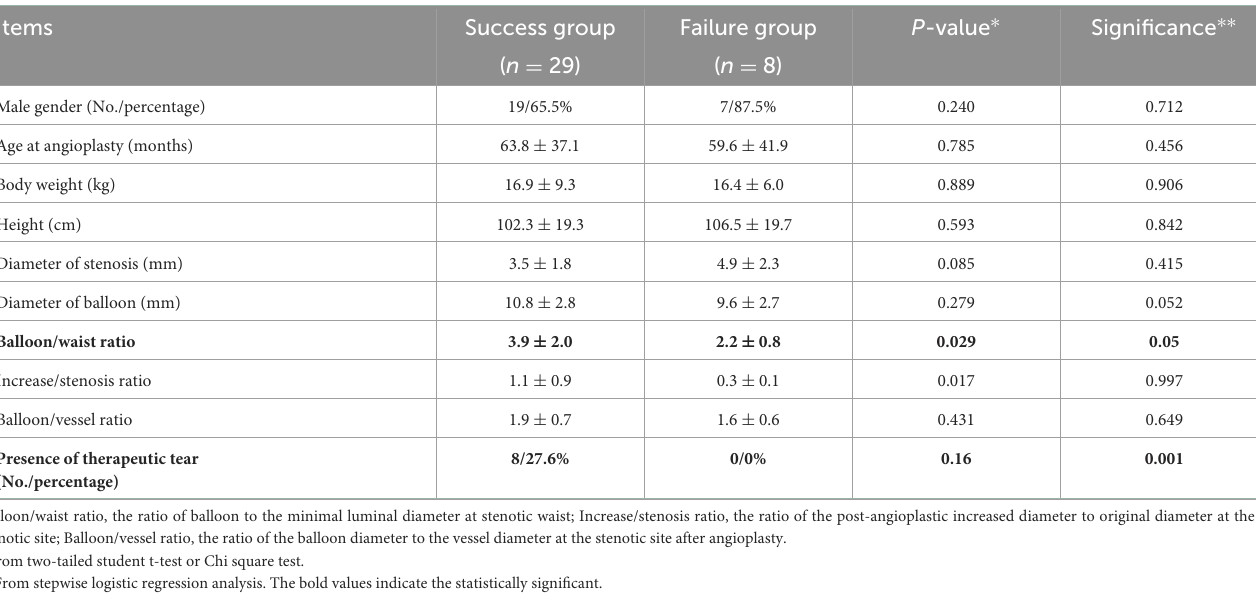
TABLE 5 Stepwise logistic regression analyses for predictors of procedural success.